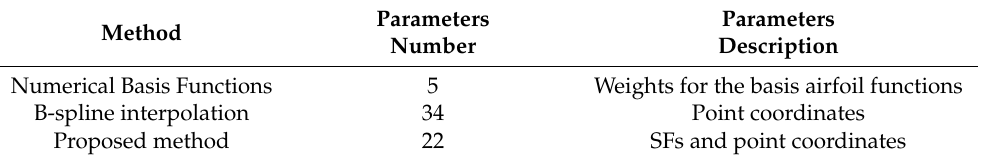
Table 12. Summary of different parameter methods for airfoils.